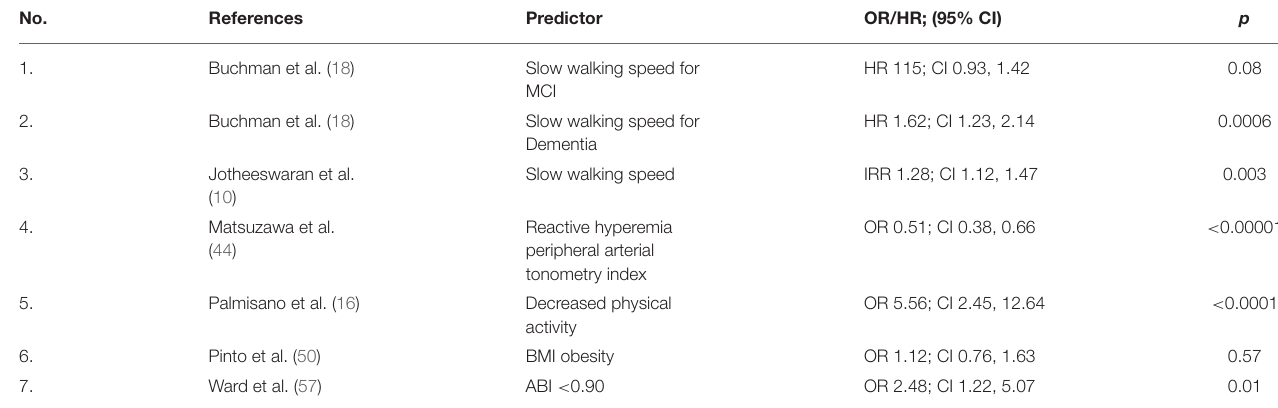
TABLE 4 | Additional predictors of